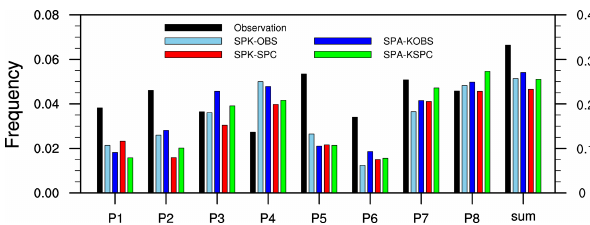
Figure 11. The frequency of strong BSISO activity (ampli- tude ≥ 1.5) in each phase (P1–P8; the left y axis) and their sum (the right y axis) for NOAA OLR and ERAI u 850 (black), SPK-OBS (light blue), SPA-KOBS (dark blue), SPK-SPC (red), and SPA- KSPC (green).